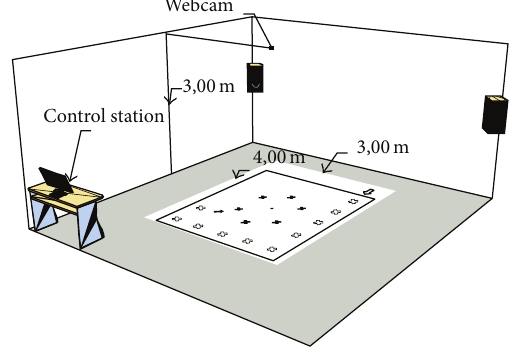
Figure 7: The Harmonic Walk ’s physical environment with camera placement, audio monitors, and control station.